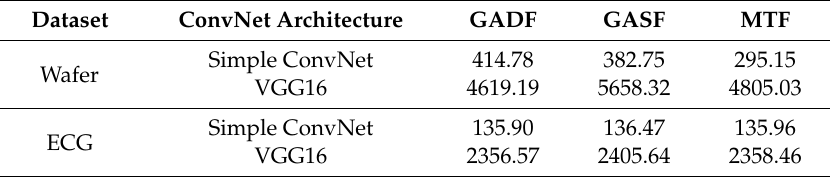
Table 3. Average execution times (in seconds) of the simple ConvNet and VGG16 in processing the Wafer and ECG dataset images, separated by three data transformation methods.